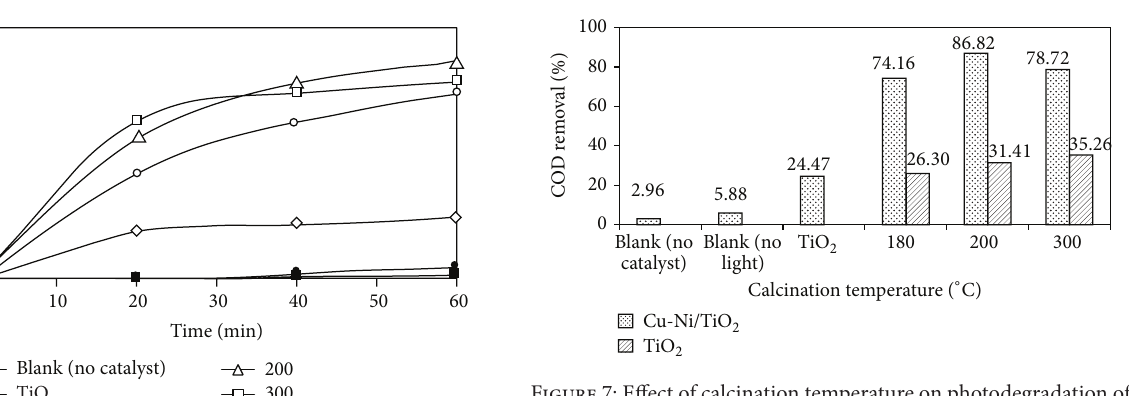
Figure 7: Effect of calcination temperature on photodegradation of DIPA using bare TiO 2 and Cu-Ni/TiO 2 photocatalysts (photocata- lysts loading = 1g ⋅ L −1 ; DIPA concentration = 100ppm; calcination temperature = 180, 200, and 300 ∘ C; irradiation time =